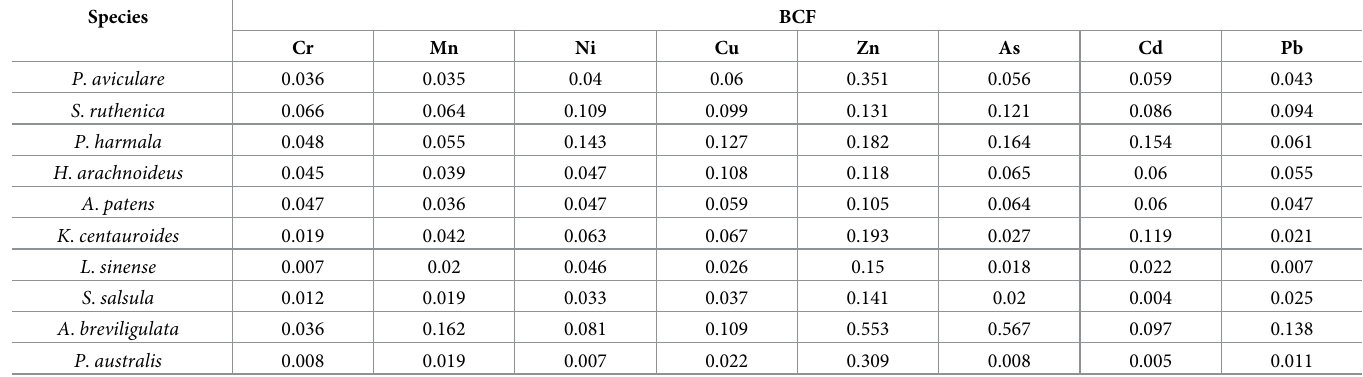
Table 4. Biological concentration factors ( BCF ) for native plants around the tailings pond.